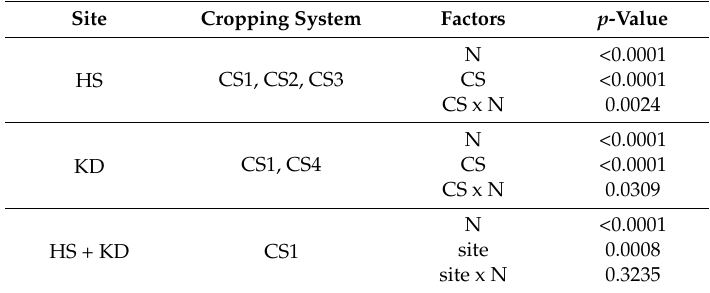
Table 4. p -values of the main effects and interactions on the whole cropping system dry matter